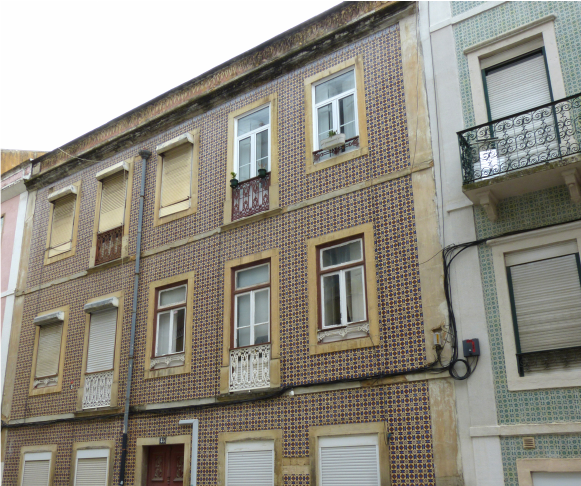
Figure 5. Lisbon, Cidade da Horta Street, n. 45, pattern P-19-00062. Photo by Az Infinitum / Rute